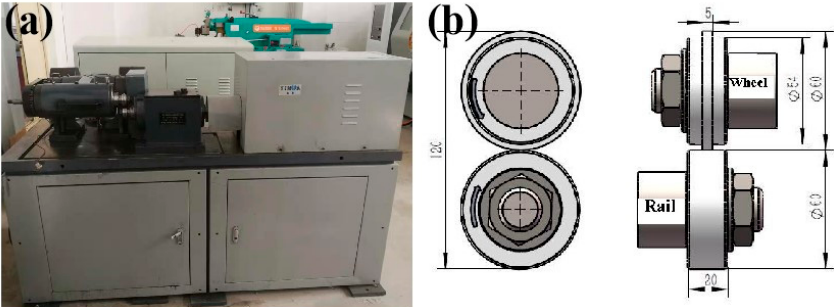
Figure 2. The test apparatus: ( a ) GPM-40 wear tester and ( b ) sample dimensions and contact mode of wheel and rail samples (unit: mm).